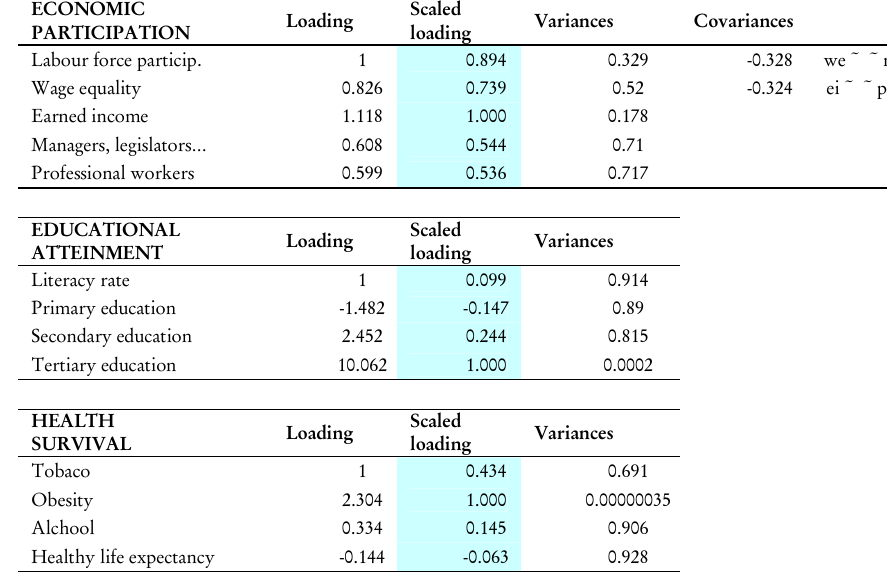
Estimates parameters of the gender gap factors